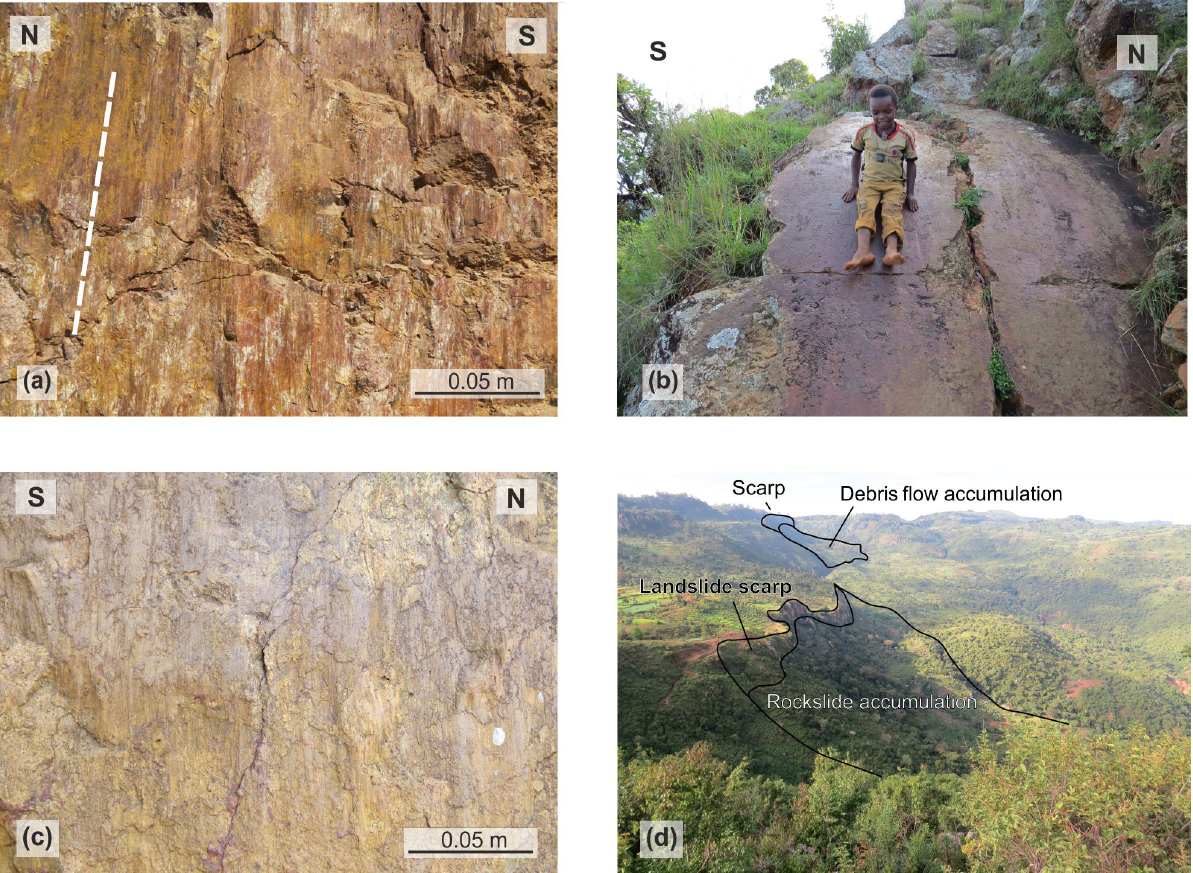
Figure 6. Field photographs. (a) Steeply dipping, N–S oriented fault plane, with steeply plunging slickensides and normal kinematic indica- tors (west of Dilla; eastern rift escarpment). (b) ESE moderately dipping normal fault, parallel with the main NNE–SSW trending western rift escarpment (Ocholo village; north of Arba Minch). (c) Steeply dipping, N–S oriented fault plane, with steeply plunging slickensides and normal kinematic indicators (Mejo plateau; ca. 60km east of the main rift valley). (d) Rockslide and debris flow on normal fault slope north of Arba